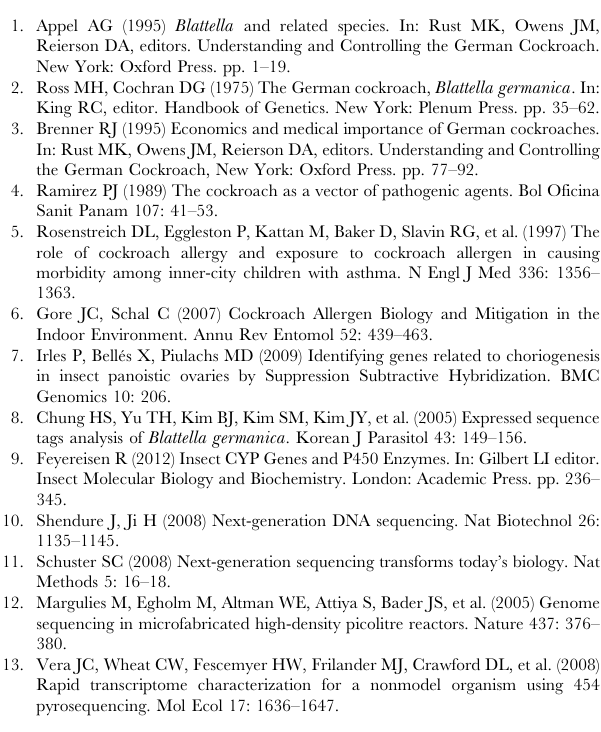
Figure S1 Three GO sub-categories for German cock- roach transcriptome. (A) Biological process, (B) Cellular component and (C) Molecular function. (TIF) Table S1 Bioassay of German cockroach susceptible (BJ-S) and resistant (DX-R) strains to different insecti- cide (KT 50 , min) using glass test method (WHO, 1963). (DOCX) Table S2 Summary of KEGG pathway types in the transcriptome of German cockroach. (DOCX) File S1 Sequences of CSP, GR, OBP, OR and top 20 abundant unigenes mentioned in the